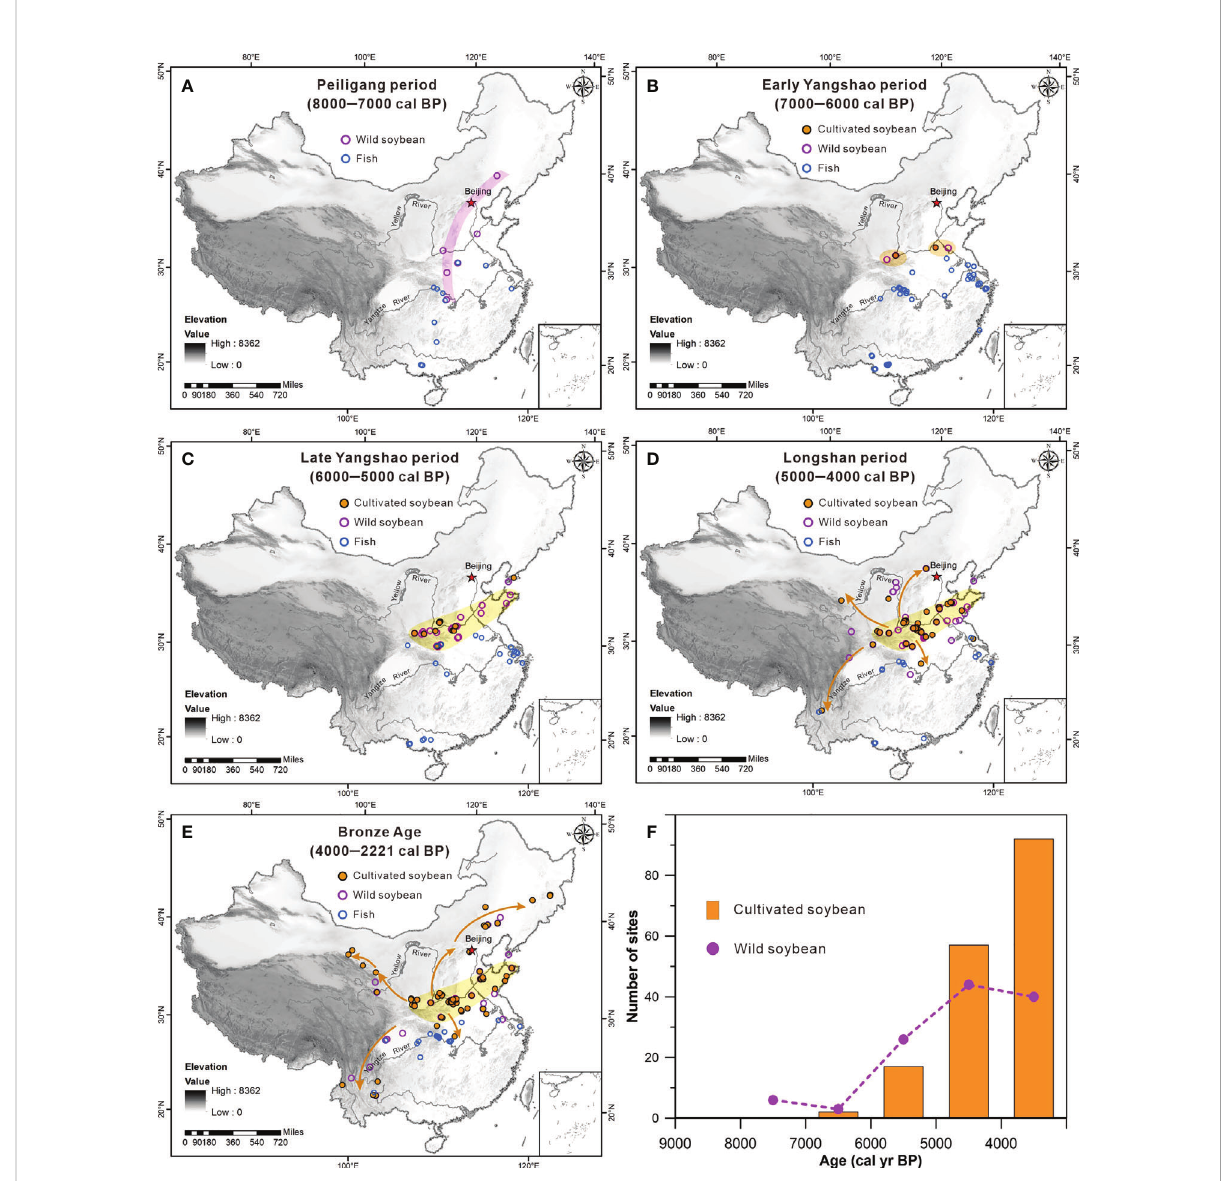
FIGURE 4 Diachronic evolution of soybeans and fi sh in the Neolithic and Bronze Age across China. The orange solid and purple hollow circulars denote sites of cultivated and wild soybeans respectively. The light-colored shades denote the core region of soybean, and the orange arrows indicate the spread routes of